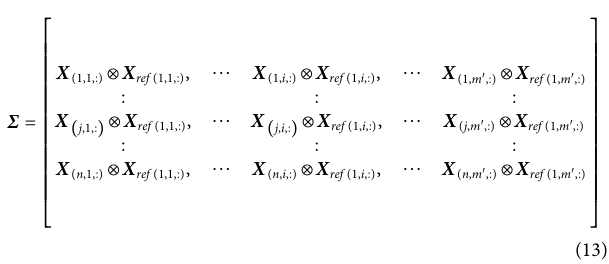
Frontiers in Chemical Engineering |